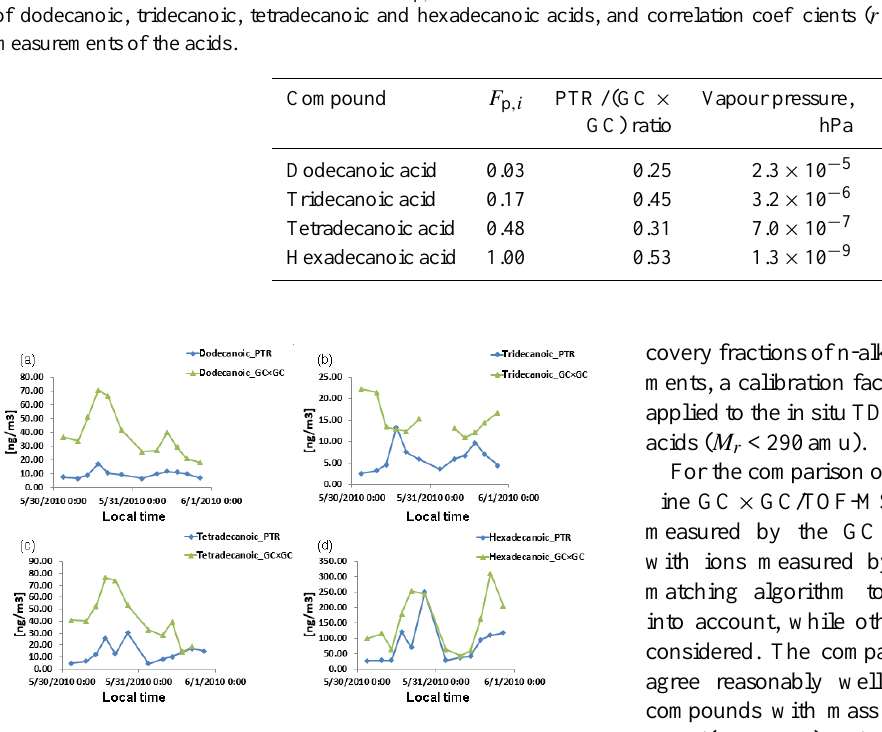
Figure 5. Time profiles for mass concentrations measured with the TD-PTR-MS and the GC × GC techniques for four alkanoic acids: dodecanoic (a) , tridecanoic (b) , tetradecanoic (c) , and hex- adecanoic (d)